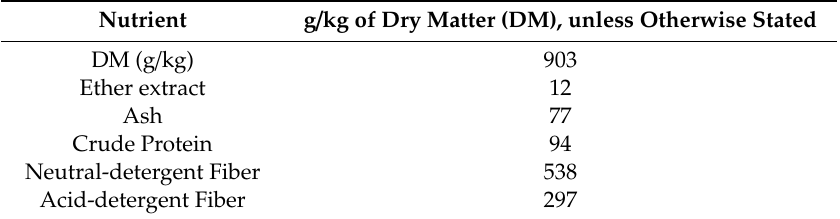
Table 1. Chemical composition of the total mixed ration (TMR) used in the experiment.